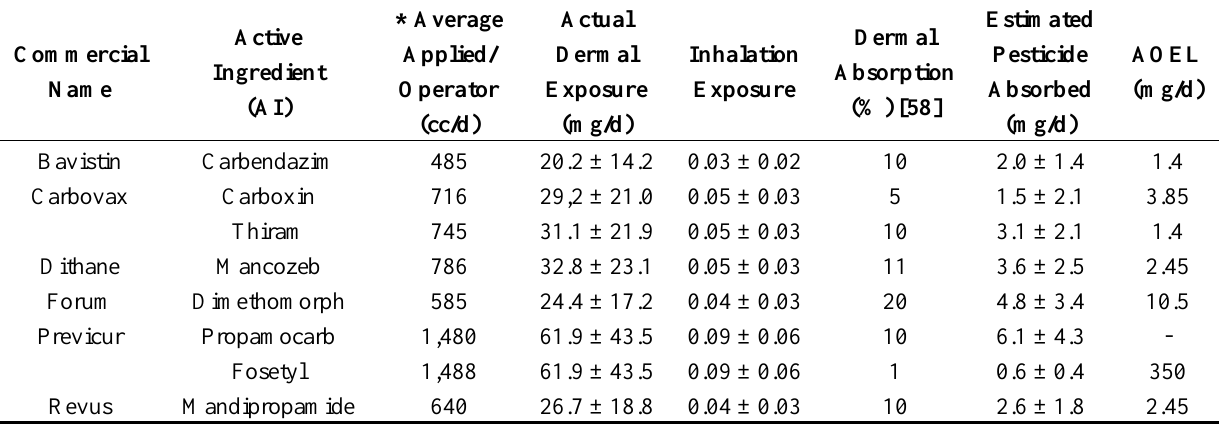
Table 2. Estimated actual dermal and inhalation exposures for 8 evaluated pesticides used in greenhouse flower crops in